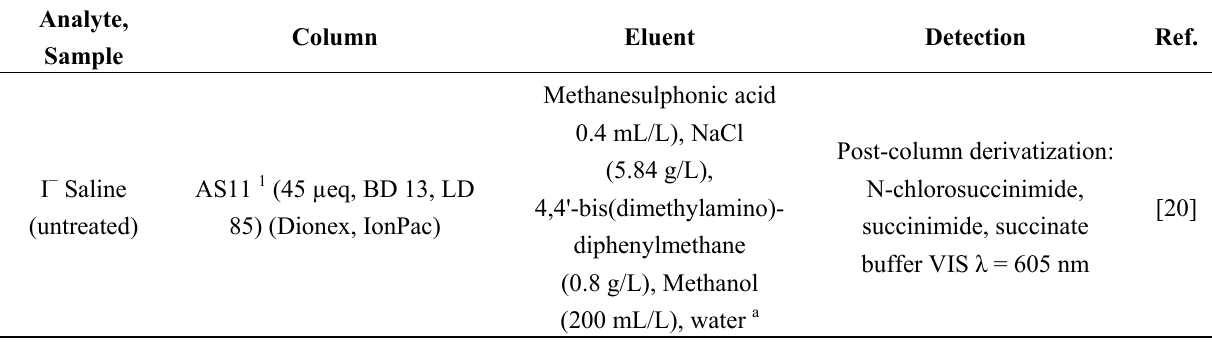
Table 2. Ion chromatographic determinations of iodide or bromide, alone or simultaneously with some other ions in waters with high ionic strength. Analyte, Column Eluent Detection Sample